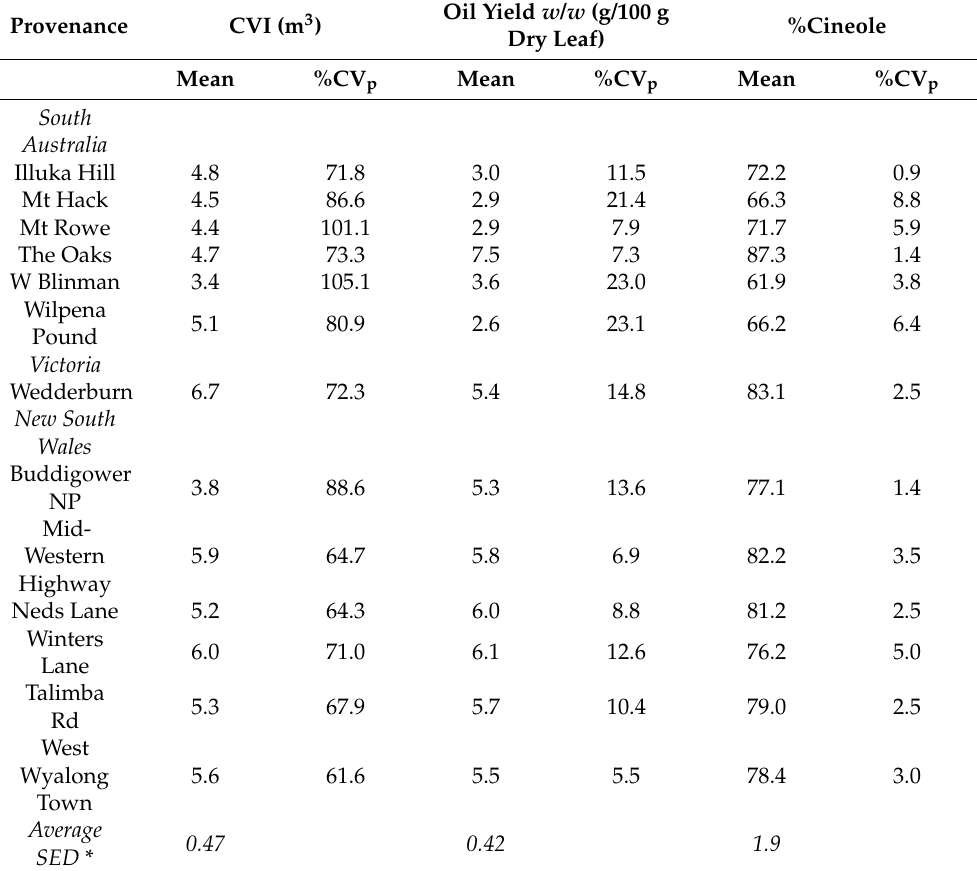
Table 2. Provenance means (best linear unbiased estimates), average standard errors of difference (SED) and coefficients of phenotypic variation (%CV p ) for CVI, oil yield and %cineole. Provenance CVI (m 3